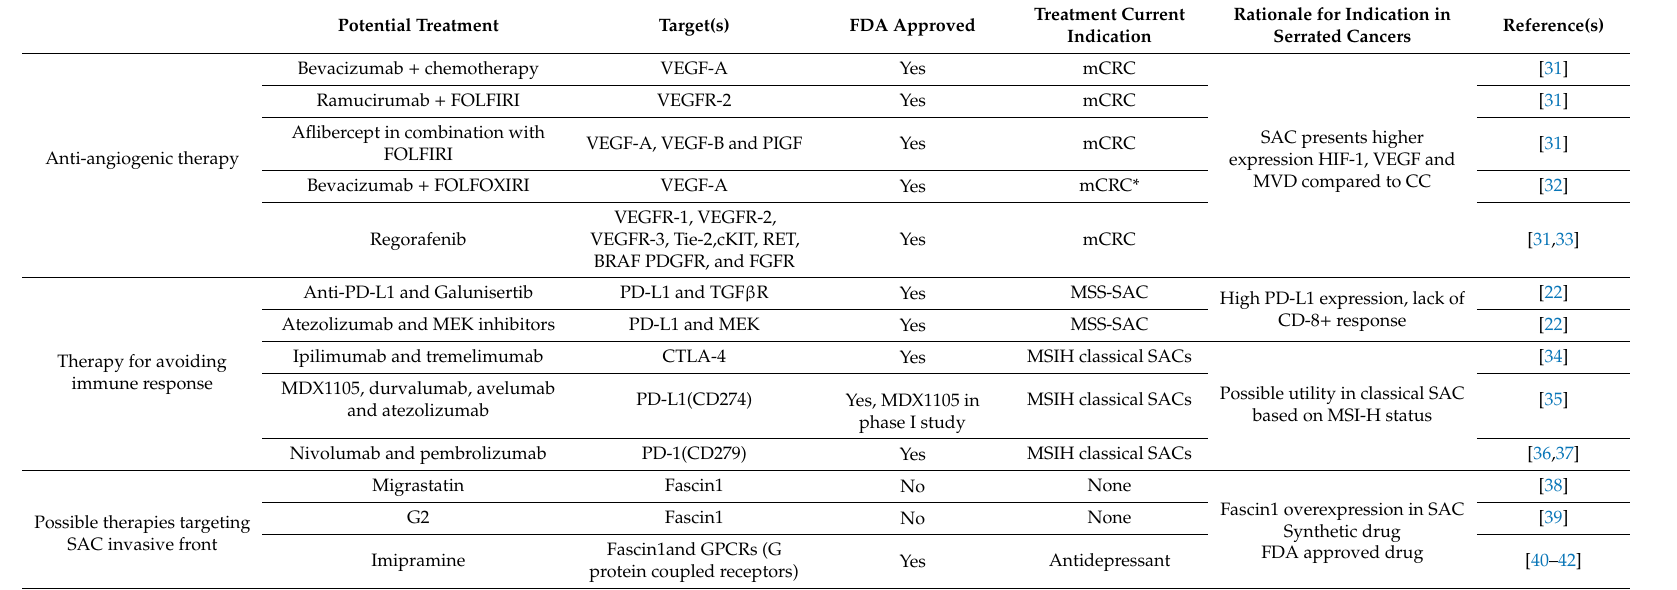
Table 1. Potential therapeutic approaches to treat tumors with SAC histology or SAC-associated